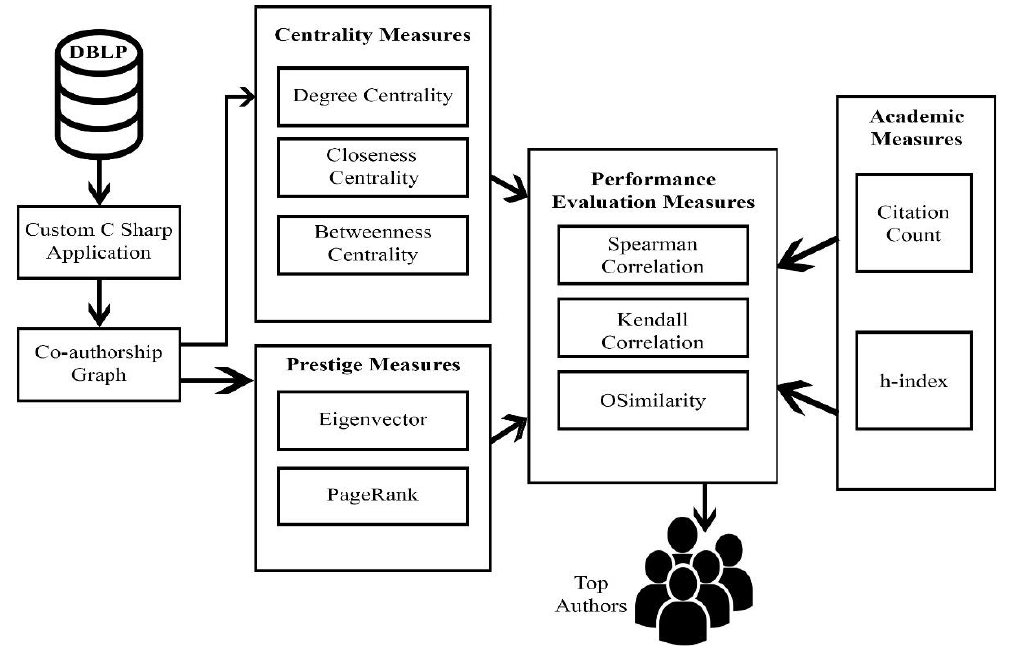
Figure 1. Ranking authors using social network measures. DBLP, the Digital Bibliography and Library Project.